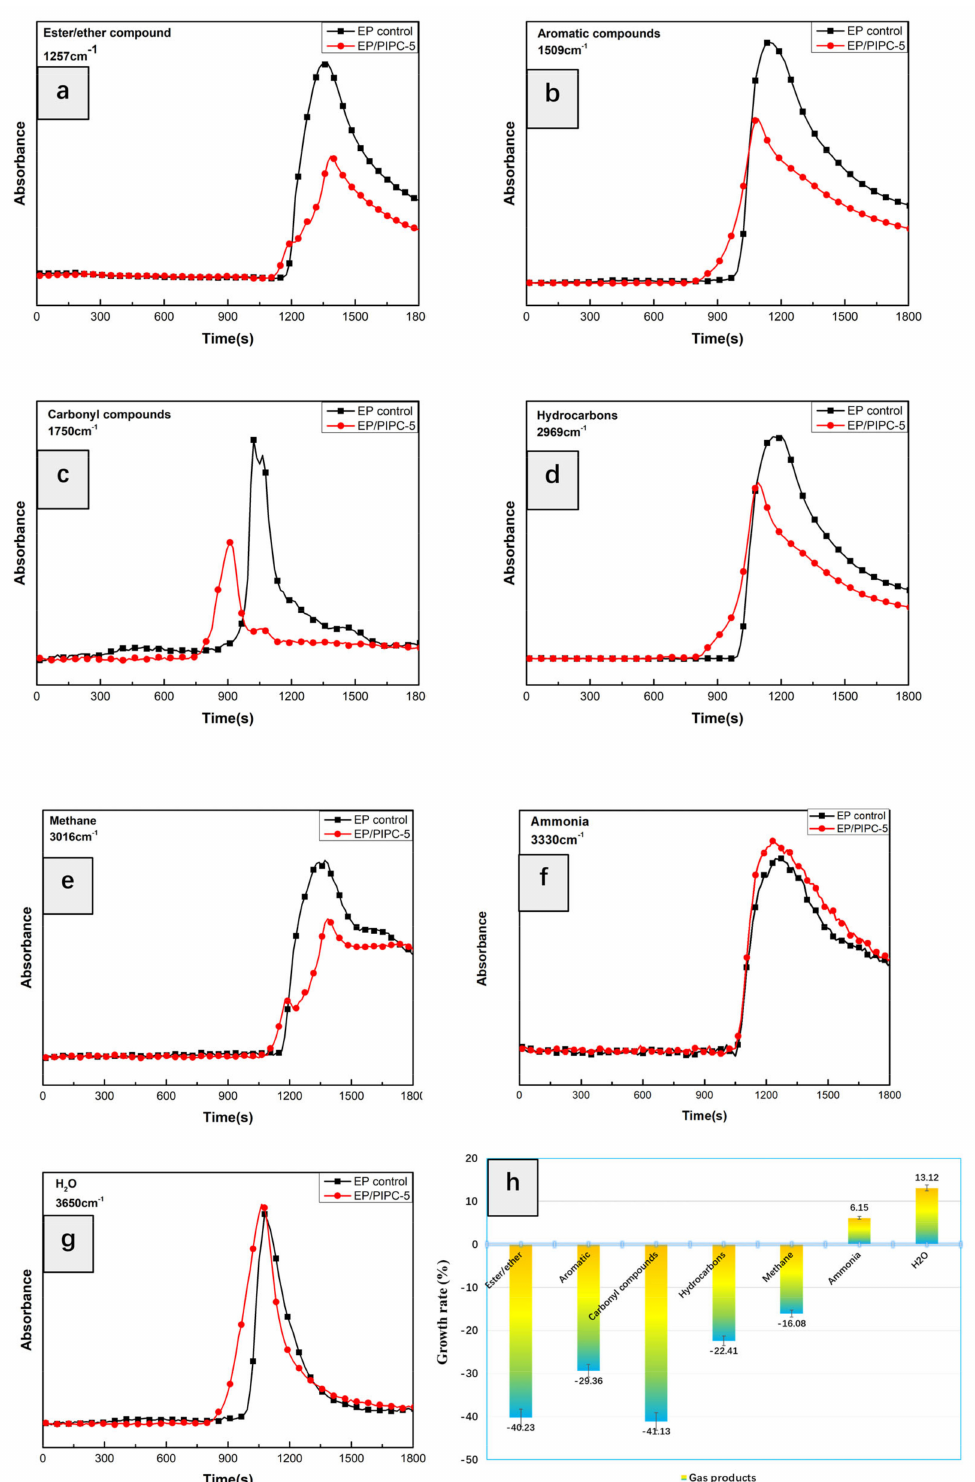
Figure 13. Absorbance of pyrolysis products for EP control and EP / PIPC-5 vs time: ( a ) ester / ether; ( b ) aromatic; ( c ) carbonyl; ( d ) hydrocarbons; ( e ) methane; ( f ) ammonia compounds; ( g ) H 2 O and ( h ) various gas pyrolysis product growth